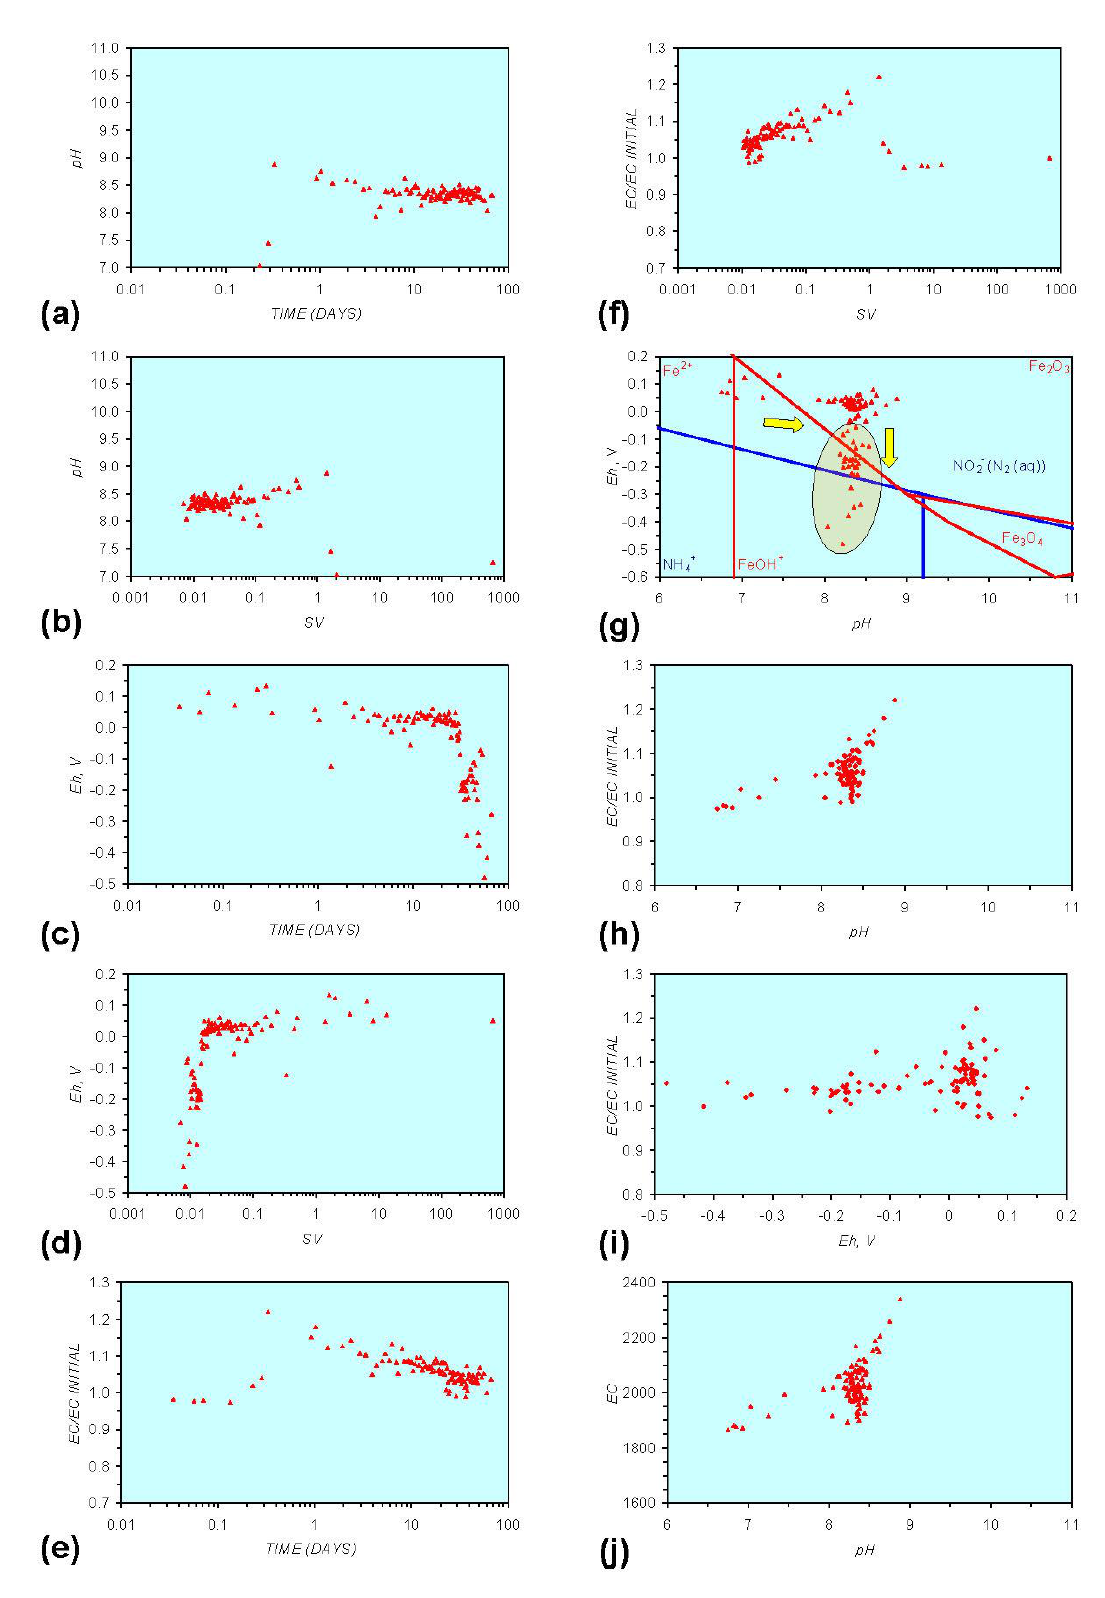
Figure A13. MR13: Ca-montmorillonite + n-Fe 0 , saline water. (a) pH vs. Time; (b) pH vs. SV; (c) Eh vs. time; (d) Eh vs. SV; (e) EC/EC Initial vs. time; (f) EC/EC Initial vs. SV; (g) Eh vs. pH (SRE ringed); (h) pH vs. EC/EC Initial; (i) Eh vs. EC/EC Initial; (j) pH vs. E(C) Arrows indicate decreasing SV and increasing